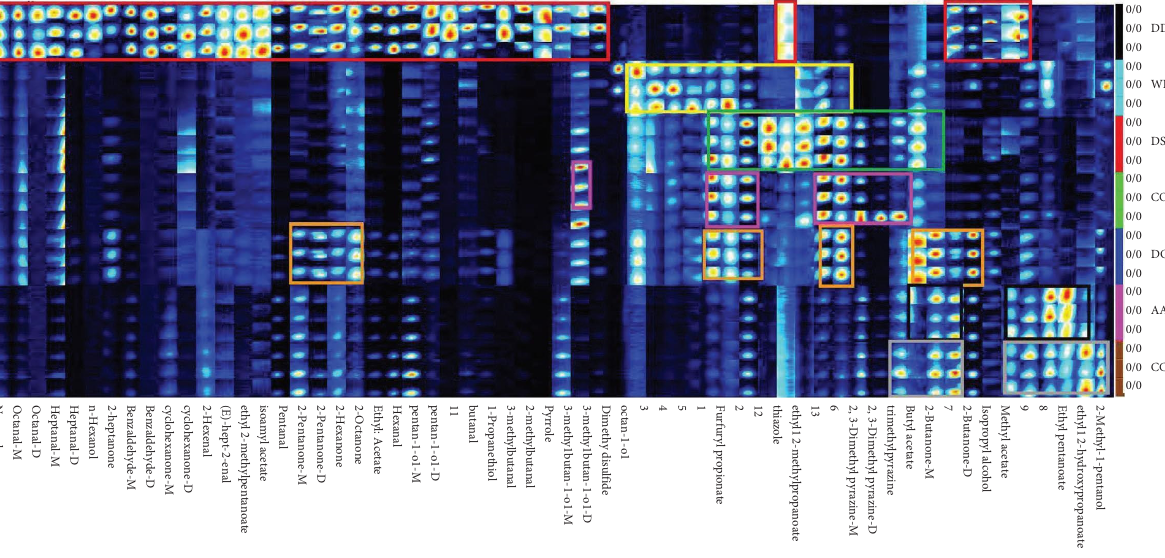
Figure 3: Gallery plot fngerprint of volatile favor compounds in Ejiao at diferent processing stages.